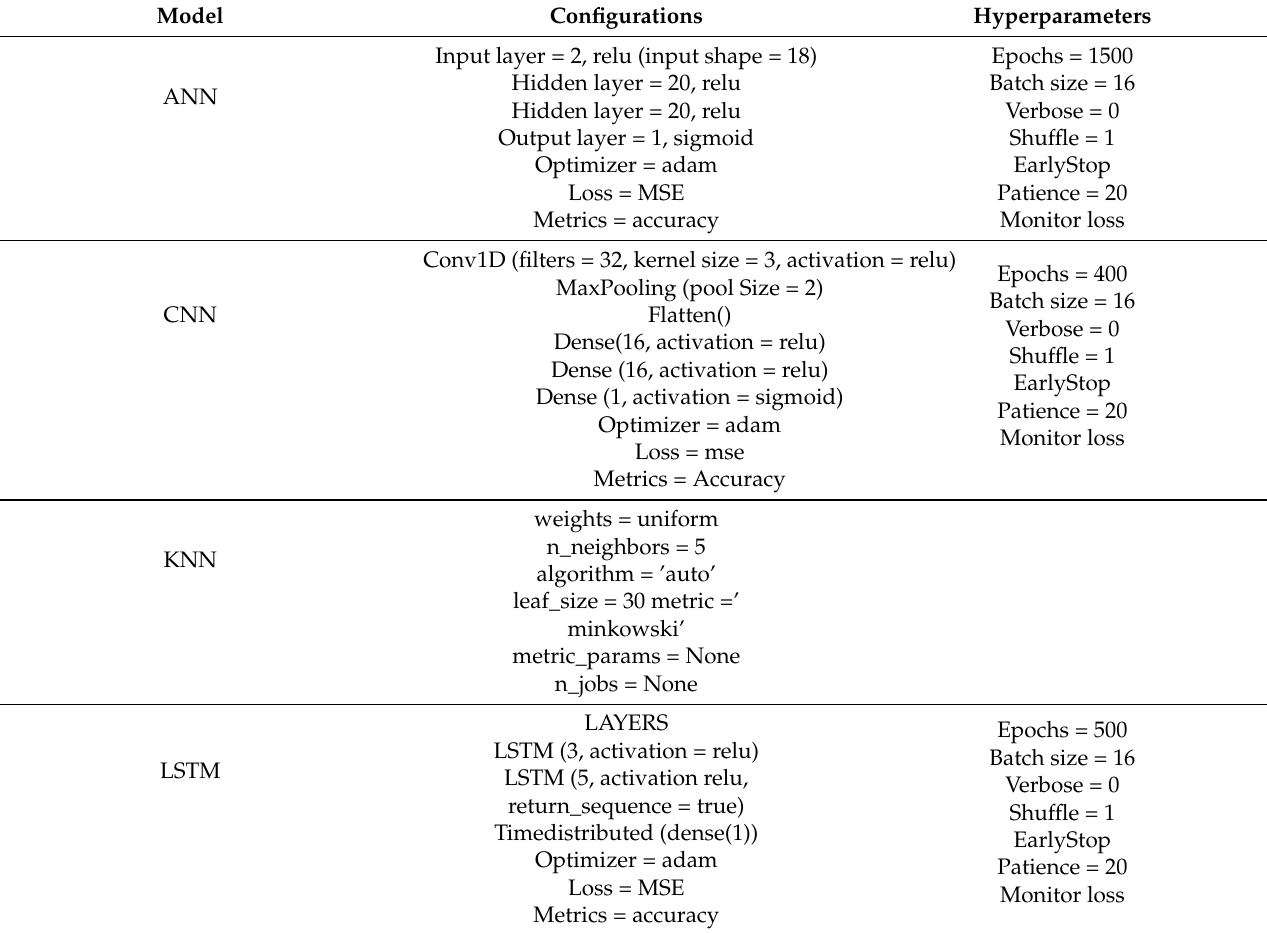
Table 5. Learning model